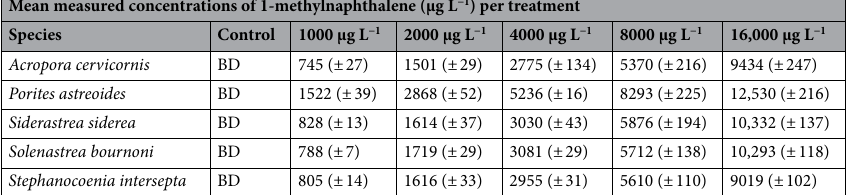
Table 1. Mean (± s.d.) (n = 4) concentrations of 1-methylnaphthalene, for each nominal treatment level in each coral species exposure. BD below laboratory detection limit of 100 µg L −1